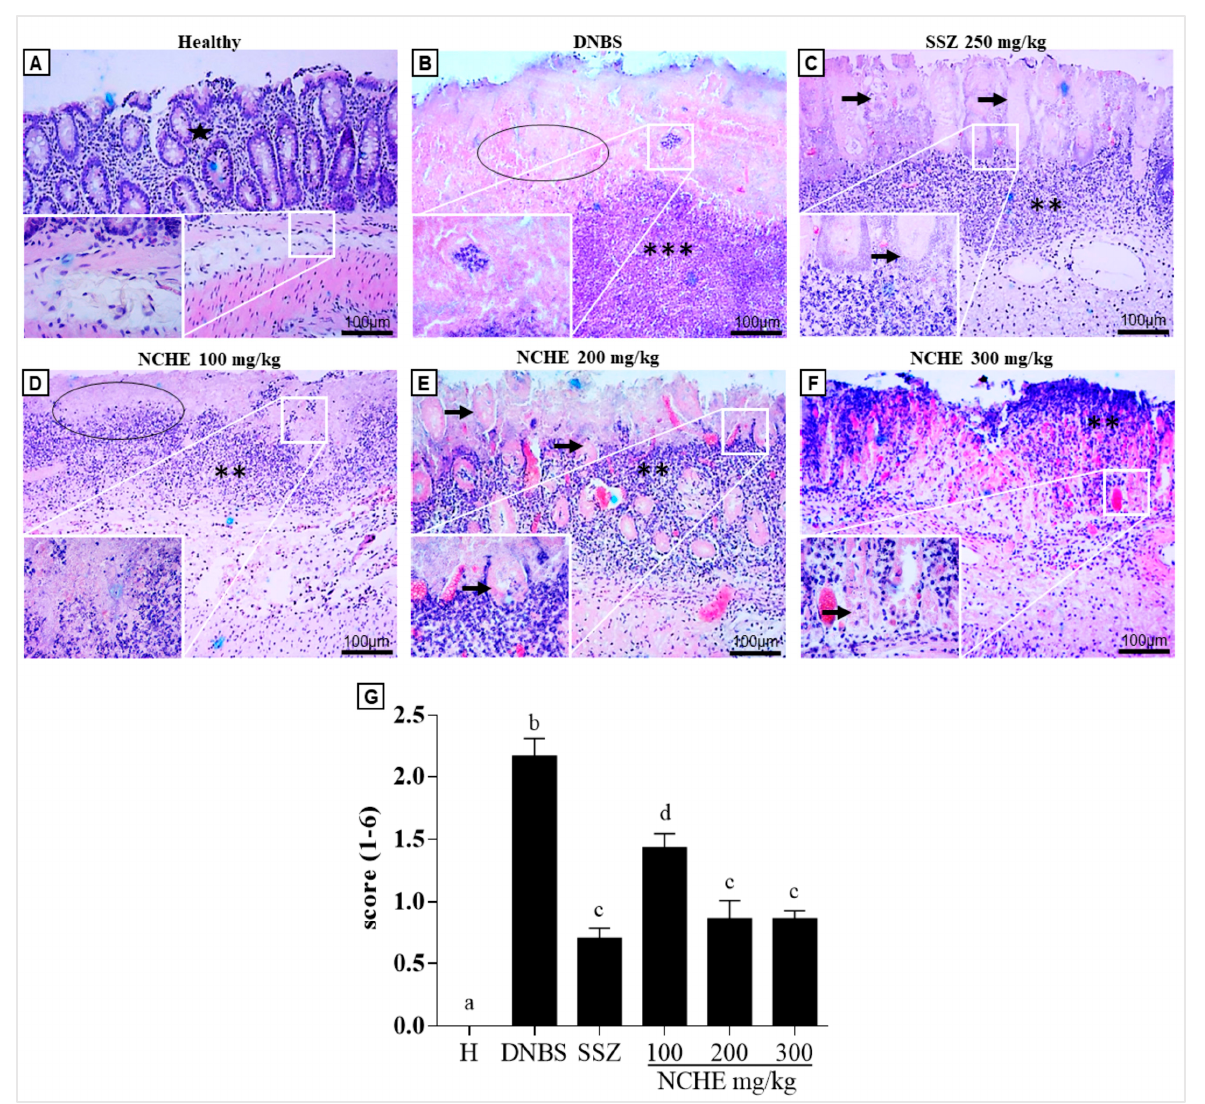
Figure 7. Histopathological analyses of representative colonic tissue (longitudinal section) using Hematoxylin/Eosin staining. Groups represented: H—healthy group ( A ), DNBS—DNBS control ( B ), Sulfasalazine (SSZ) (250 mg/kg) ( C ) and NCHE— N. cochenillifera hydroethanolic extract (100, 200 and 300 mg/kg) ( D – F ) and histopathological score ( G ). The figure represents microscopic damage assessment (10 × and 40 × magnification). Normal intestinal layers (star), inflammatory cell infiltrate intense (***) and moderate (**), total mucosal ulceration (circle), Initial mucosal regeneration (arrow). Data are expressed as means ± SEM. Groups with a different letter differ statistically ( p < 0.05).